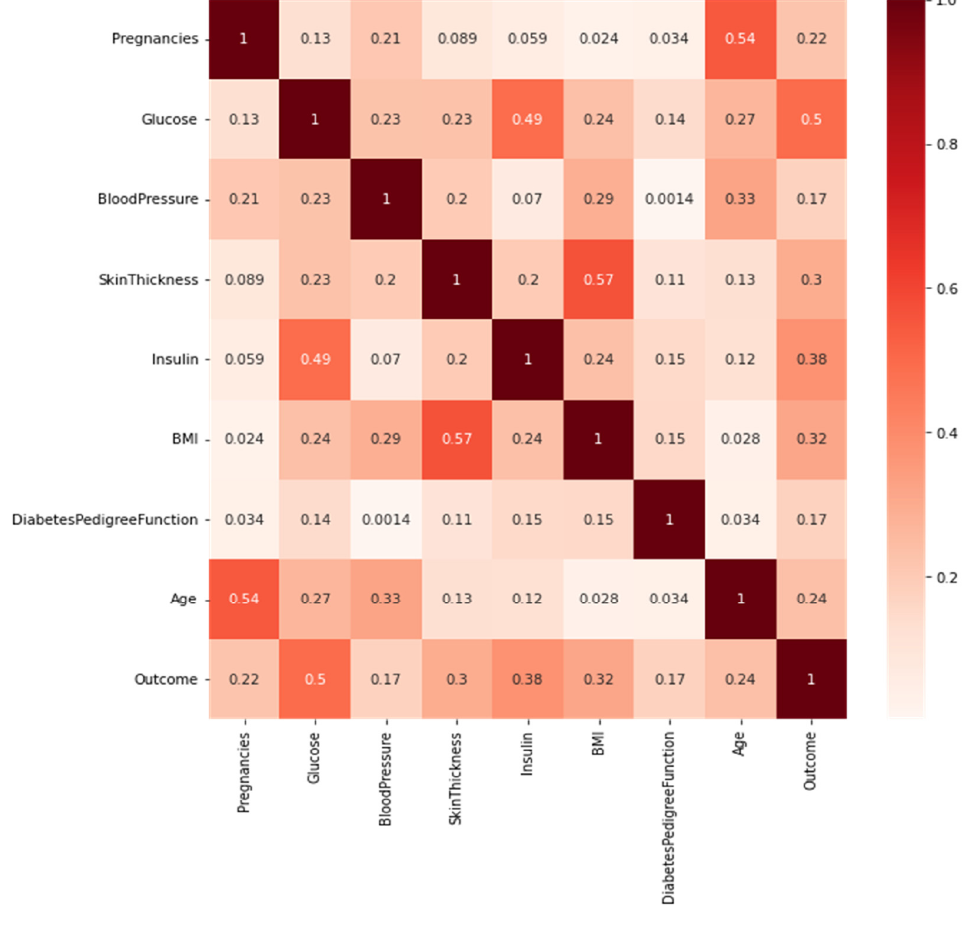
Figure 3. Heatmap of Pearson’s correlation coefficients for all diabetes features.